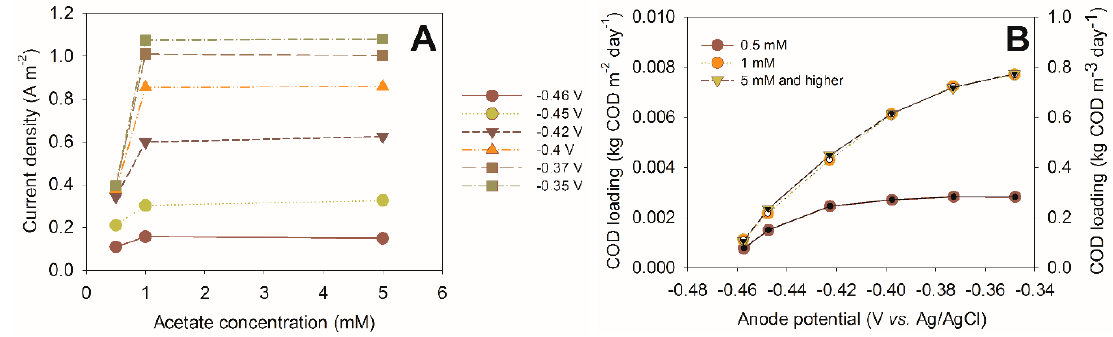
Figure 4. ( A ) Current density as a function of acetate concentration at different overpotentials (calculated from [28]) and ( B ) the same current density represented as COD loading as a function of the anode potential. The COD loading is expressed per m 2 of anode surface area (left axis) and per m 3 of reactor using a specific anode surface area of 100 m 2 ·m − 3 .